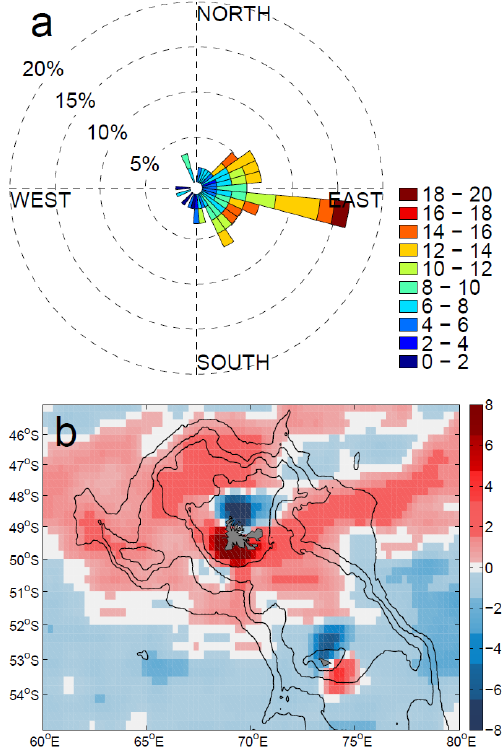
Figure 7. (a) Rose histogram for daily wind direction and speed (colors; in ms − 1 ) in October and November 2011, during the KEOPS-2 expedition. (b) Wind-stress curl (in 10 − 7 Nm − 3 ) in Oc- tober and November 2011. Winds are derived from the CCMP prod-